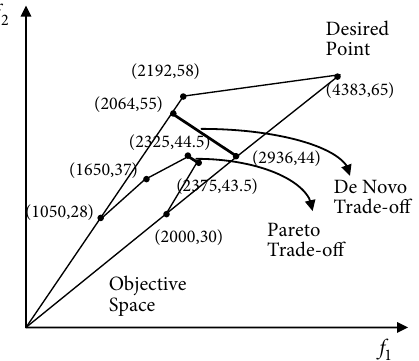
Fig. 4. A comparison of objective